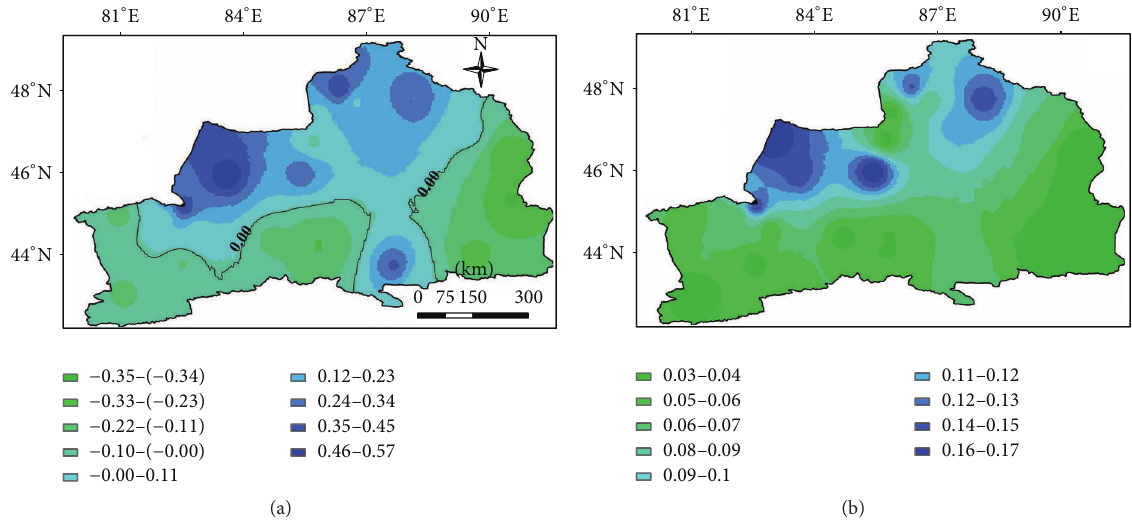
Figure 2: Spatial distributions of anomalies (a) and trends (b) of AI in North Xinjiang, China, between 1961 and 2013.